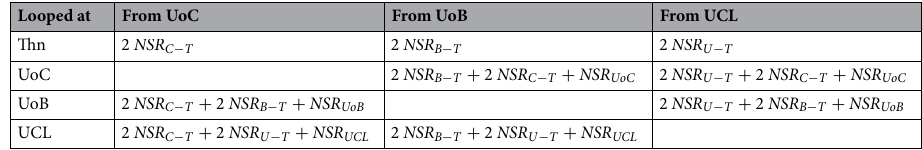
Table 1. Loop-back NSR. Analytical NSR of each loop-back path after the NSR of the transceiver back to back through its local node has been removed.